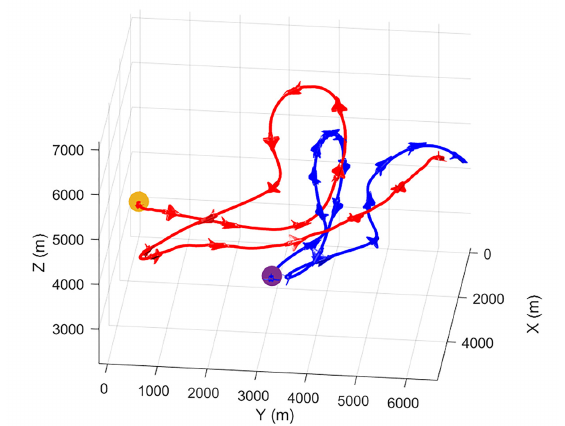
Figure 18. The two UCAV tracks in the later training period in case 3.